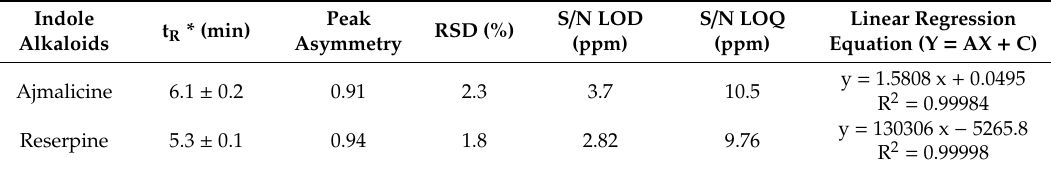
Table 2. Characteristics of reverse phase HPLC (RP-HPLC) method development and validation for reserpine (RES) and ajmalicine (AJM).